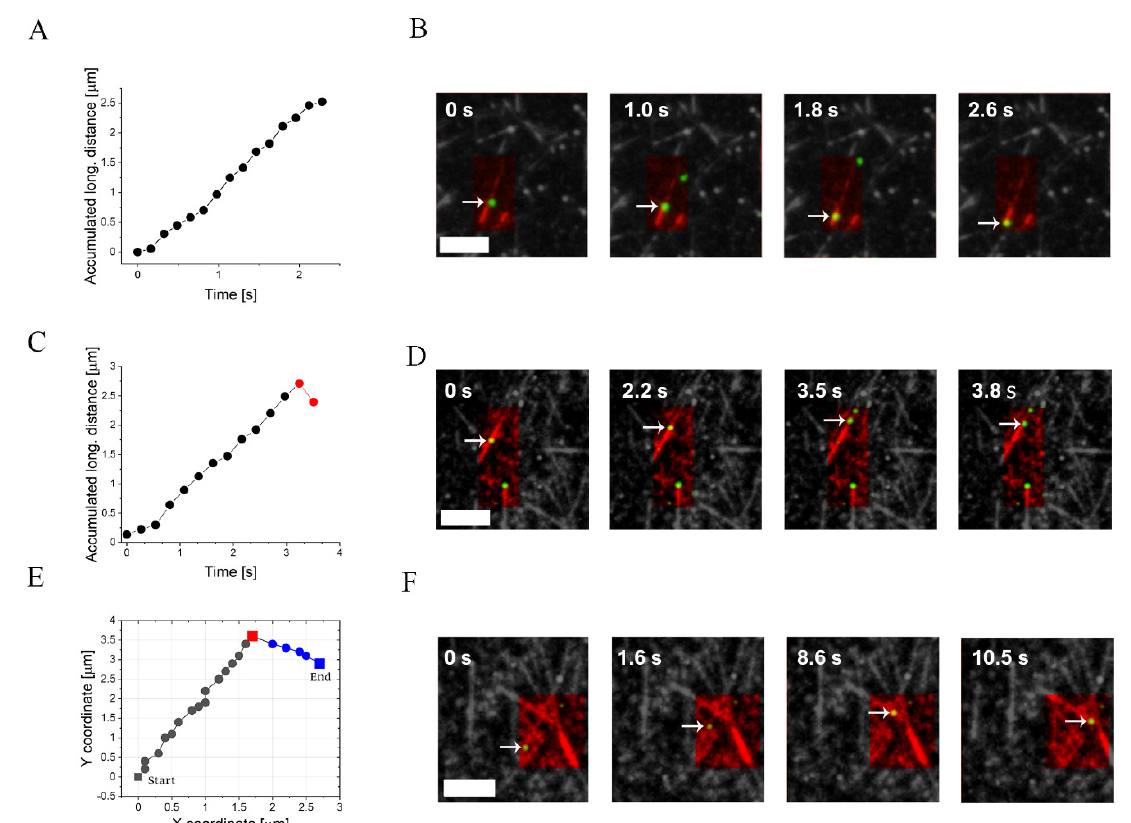
Figure 3. Examples of the NP motion modes. The two first rows show the accumulated longitudinal distance of an NP (marked by an arrow) and the corresponding snapshots for different motion modes. ( A , B ) Directed motion of an NP moving towards MT minus-end (marked-end MTs are shown). ( C , D ) Minus-end directed motion with a backward (plus-end) step at the end of the NP trajectory. ( E , F ) Trajectory of an NP (marked by an arrow) traversing between crossing MT tracks. The MT tracks are colored in red and the NPs in green. Conditions: [ NLS ] = 0.05 µ M, [CE] = 3.4 mg/mL (system III). The interval between frames is 0.27 s . The mean radius of the bare NP is 20 nm . Scale bars are 5 μm in all images.